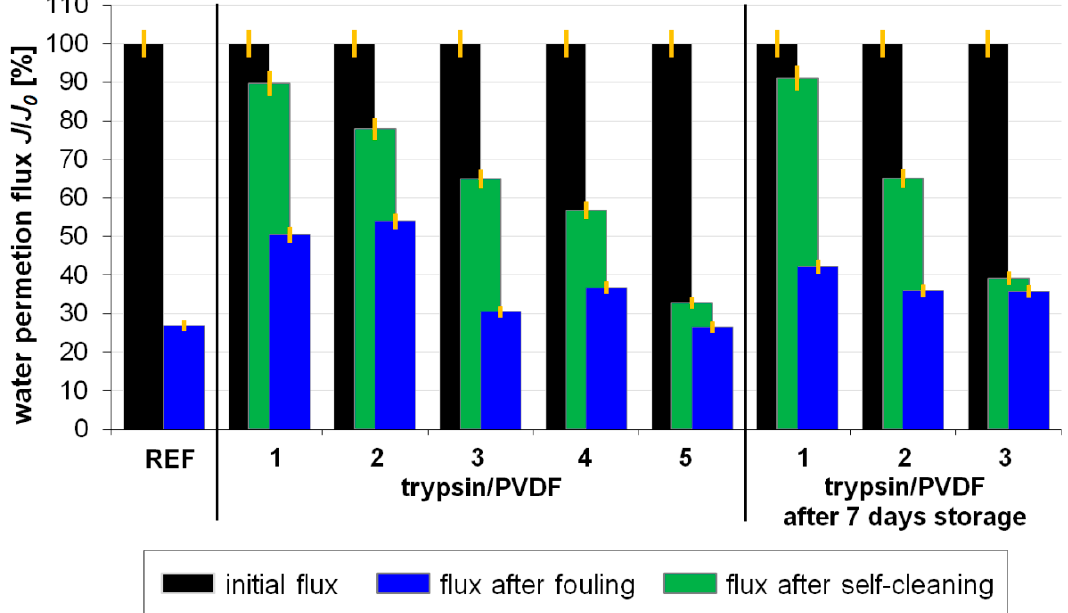
Figure 5. Fouling and self-cleaning properties were characterized by initial water permation flux, water flux after fouling treatment, and water flux after self-cleaning. Displayed are PVDF reference membrane A (prior to enzyme immobilization, REF), as well as trypsin/PVDF membranes A after repeated fouling cycles (1–5; 1–3) determined directly after enzyme immobilization, and after one week of storage, respectively.